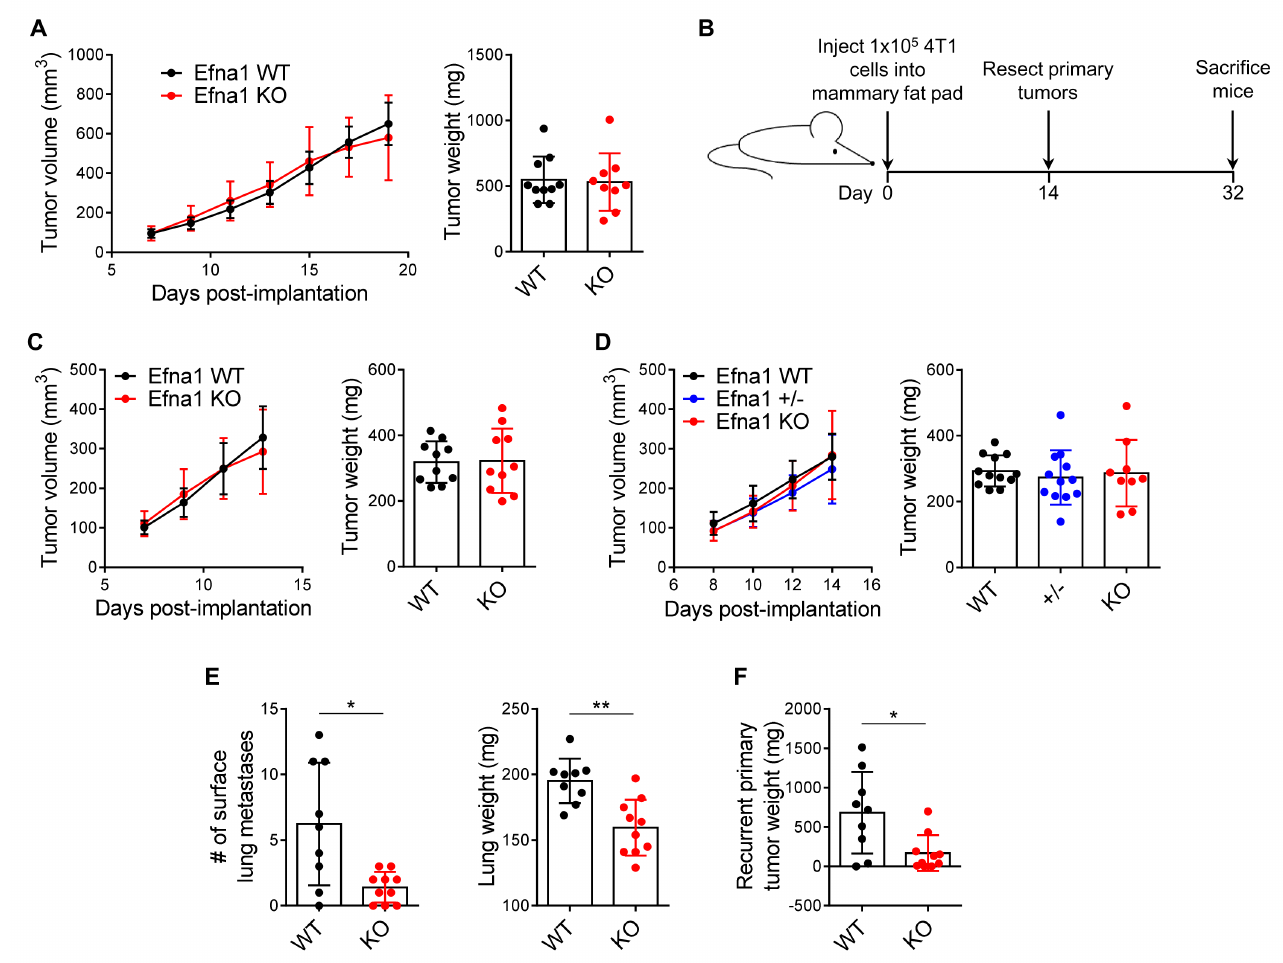
Figure 1. Ephrin-A1-deficient hosts have reduced metastasis and tumor recurrence but no difference in primary tumor growth. ( A ) 4T1 primary tumor growth curves in age-matched female Efna1 +/+ (WT) and Efna1 -/- (KO) mice and resulting tumor weights at day 21 post-implantation. ( B ) Schematic diagram showing experimental procedure for evaluating spontaneous metastases. ( C ) 4T1 primary tumor growth curves in WT and KO mice and resultant tumor weights at time of surgical resection on day 14. ( D ) 4T1 primary tumor growth curves in WT, heterozygous (+/-) and KO littermates and resultant tumor weights at time of surgical resection on day 14. ( E ) Blinded quantification of visible lung metastases and lung weights from WT and KO mice at experimental endpoint on day 32. ( F ) Weights of recurrent 4T1 tumor at primary site 18 days after surgical resection. Data shown are averages ± SD with each data point representing an individual mouse ( n =9–12 mice per group). * p <0.05, ** p <0.01 (unpaired Mann-Whitney U